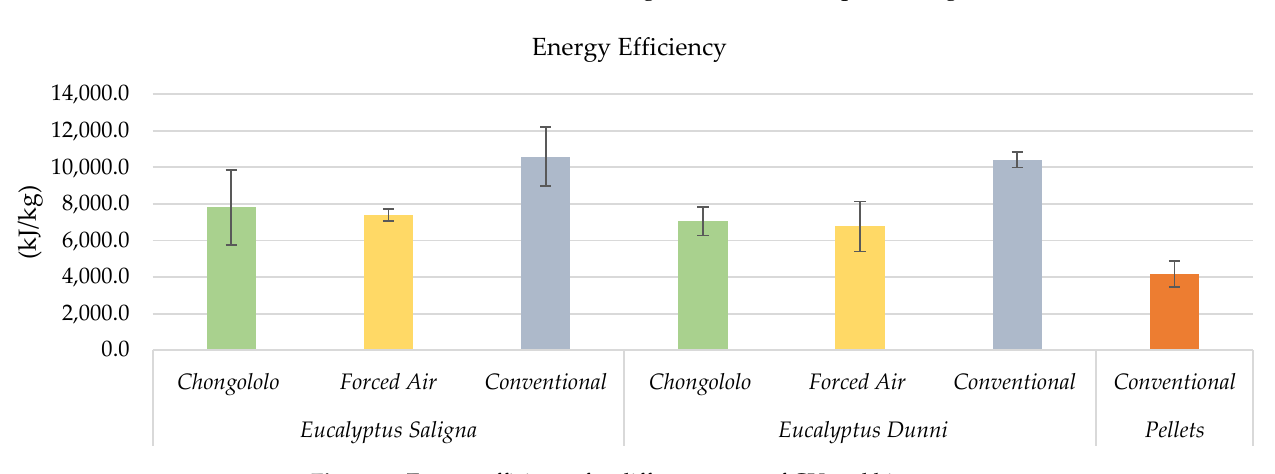
Figure 3. Energy efficiency for different types of CU and biomass.